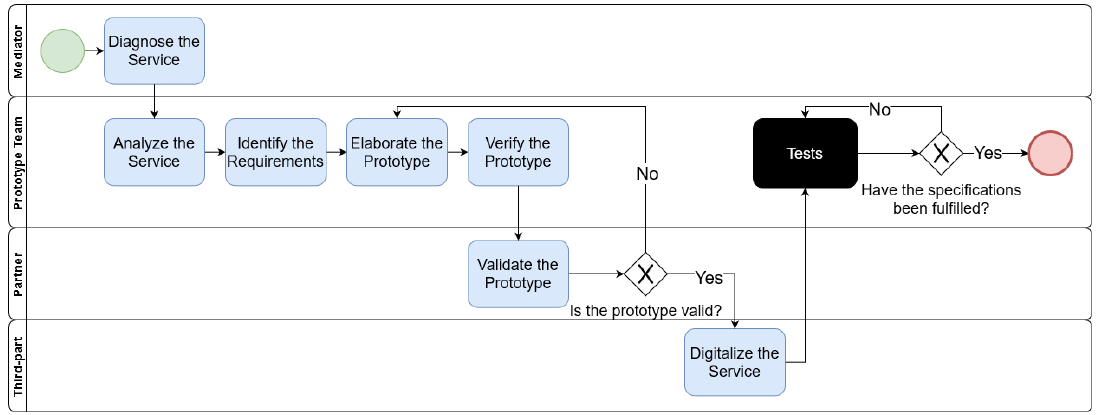
Figure 4. Prototyping